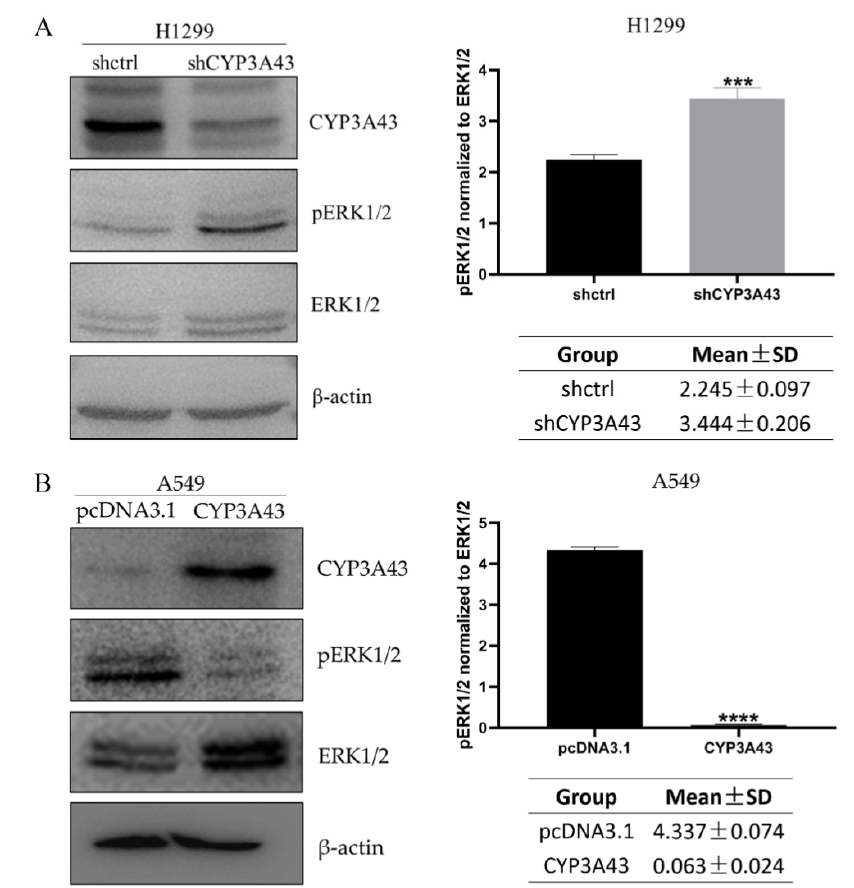
Figure 7. The expression of CYP3A43 affects ERK1/2 phosphorylation. ( A ) Increased ERK1/2 phosphorylation levels were detected in H1299-shCYP3A43 cells compared to the control group. ( B ) Decreased ERK1/2 phosphorylation levels were detected in A549-CYP3A43 cells compared to the control group. These results are shown as mean ± SD, n = 3. ***, p < 0.001; ****, p < 0.0001. L1 (CCNL1), and cyclin L2 (CCNL2)) were screened with overlapping gene identification